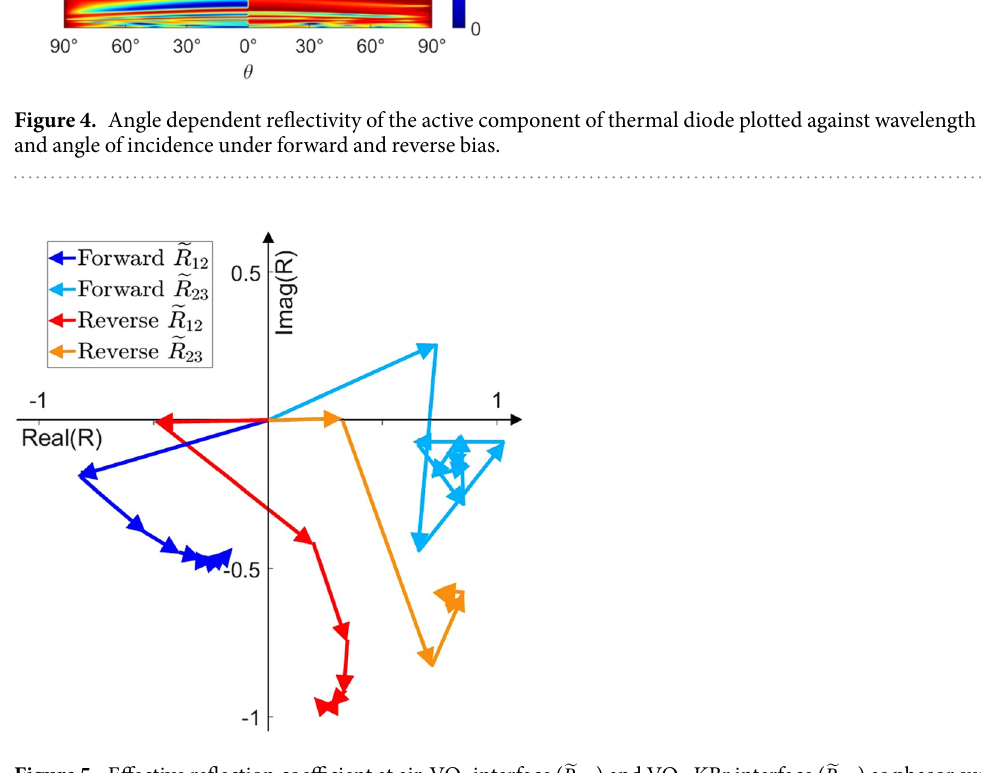
) and VO 2 -KBr interface (  R ) as phasor sum 1,2 2,3